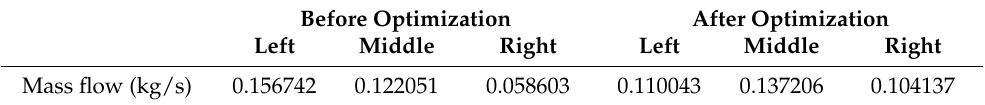
Table 8. Air mass flow of each guide channel before and after optimization. Before Optimization After Optimization Left Middle Right Left Middle Right Mass flow (kg/s) 0.156742 0.122051